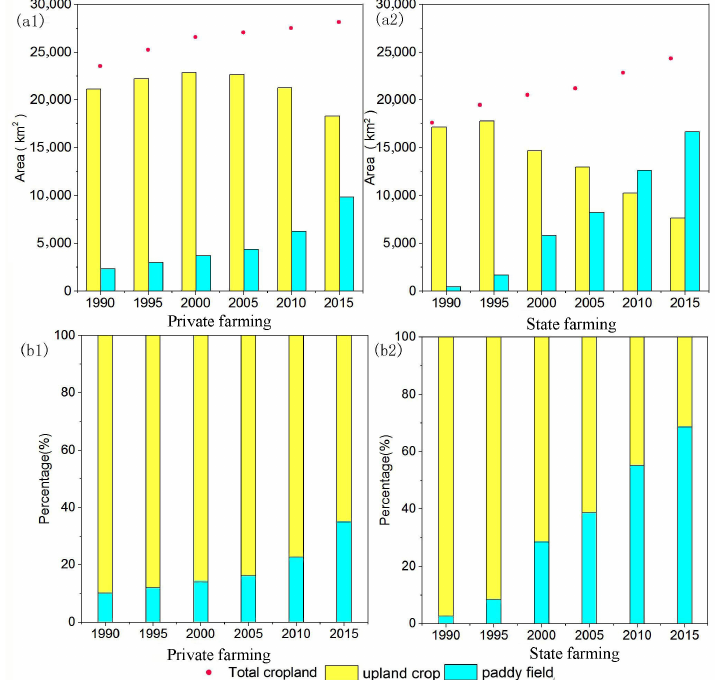
Figure 7. The total cropland area and the areas covered by upland crop and by paddy field in the state and private farming are showed in Figure 7(a1,2). The percentage of total croplands occupied by paddy field and by upland crop in the state and private farming are showed in Figure 7(b1,2).